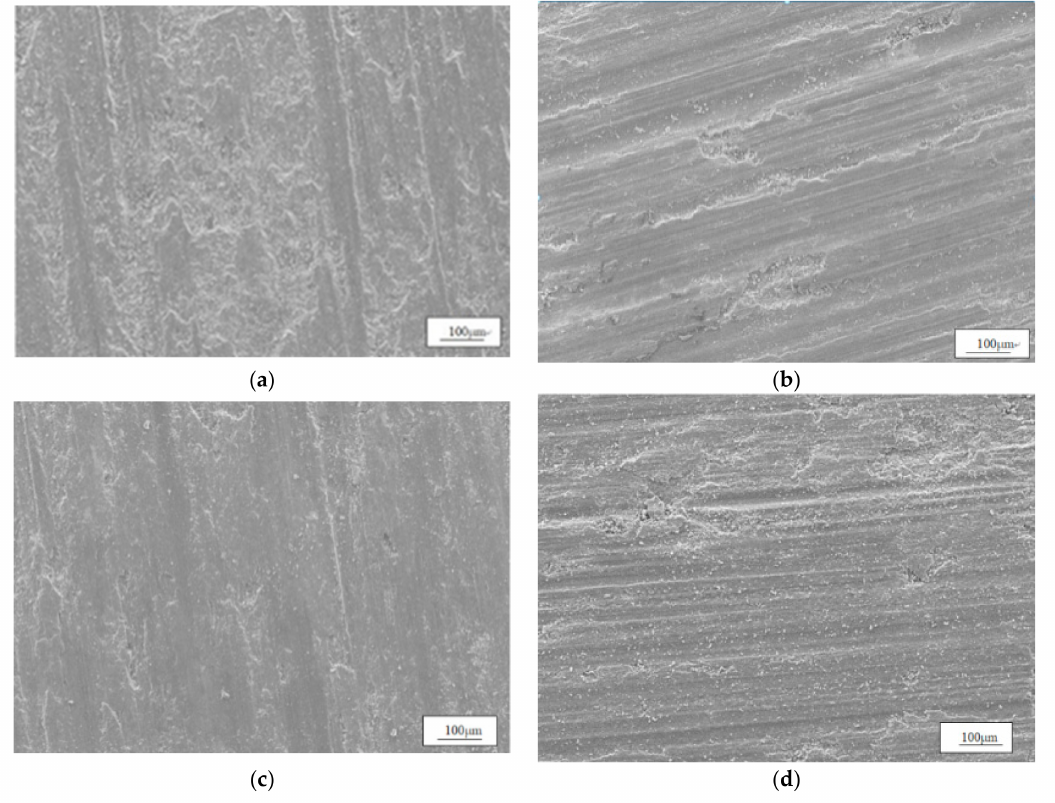
Figure 18. Wear morphology of AA6061 / 5 vol.% N-SiCp sintered at: 450 ( a ), 550 ( b ), 600 ( c ), 650 ( d ) ◦